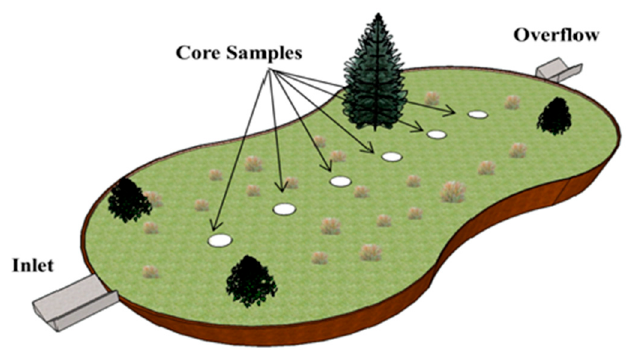
Figure 2. Soil core sampling layout at bioretention cells with approximate core locations.